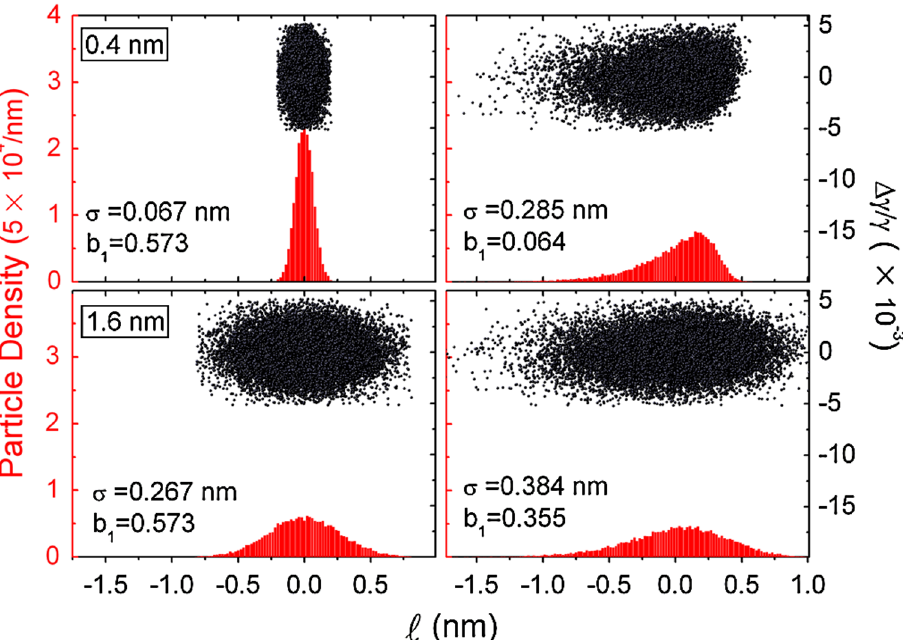
¼ 0 : 4 nm (top) and (cid:3) ¼ 1 : 6 nm (bottom). r r